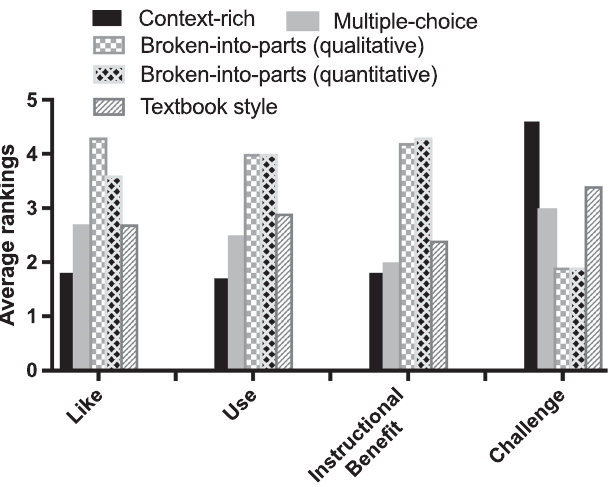
FIG. 2. Average rankings of the problem types presented to